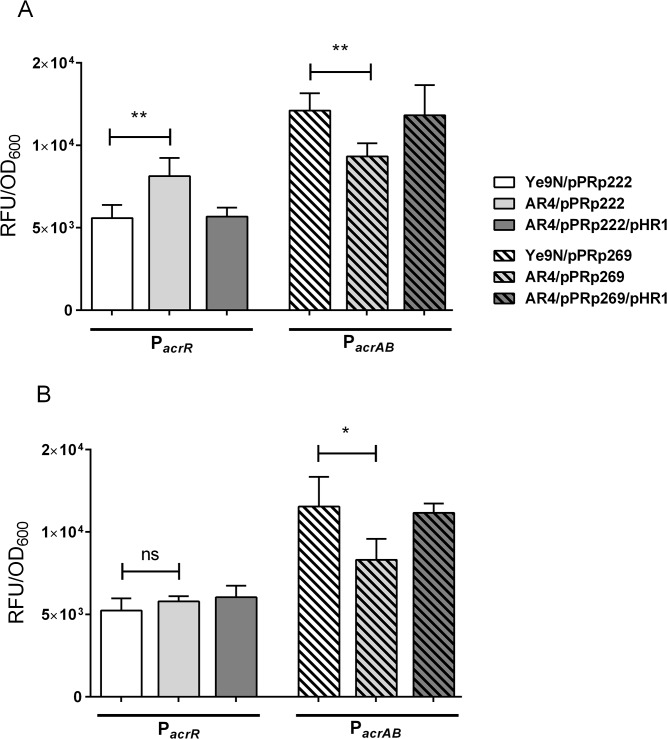
Effect of OmpR and growth phase on acrR and acrAB promoter activity.Strains Ye9 and AR4 carrying the promoter-gfp fusion constructs were cultivated in LB medium at 27°C to exponential phase (A) and stationary phase (B). Data represent mean fluorescence activity values normalized to the OD600 of the culture (± standard deviation) from three independent experiments performed in triplicate. The significance of differences between the values was calculated using Student’s unpaired t-test (ns [non significant]—p>0.05, *—p<0.05, **—p<0.01).